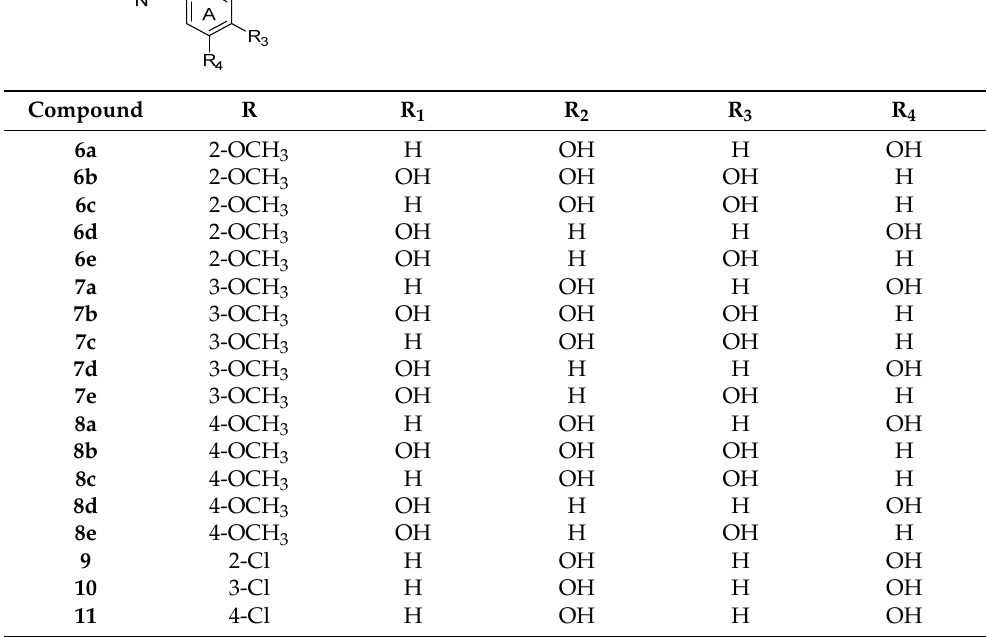
Table 1. Substitution pattern of ( E )-benzaldehyde O -benzyl oximes 6a–e , 7a–e , 8a–e , and 9–11 .